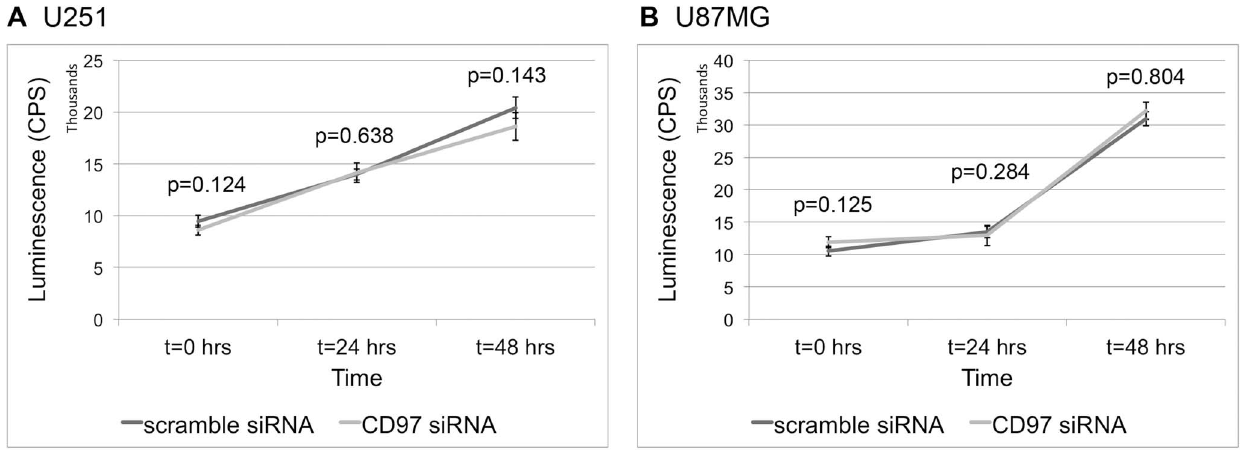
Figure 6. CD97 does not affect cell proliferation. U251 and U87MG cells were subjected to siRNA-mediated knockdown of CD97. Cells were quantified using an ATP-based luminescent assay, with luminescence quantified in counts per second (CPS). In both U251 (A) and U87MG (B) cells, there was no difference in proliferation at 24 and 48 hours after confirmed protein knockdown.